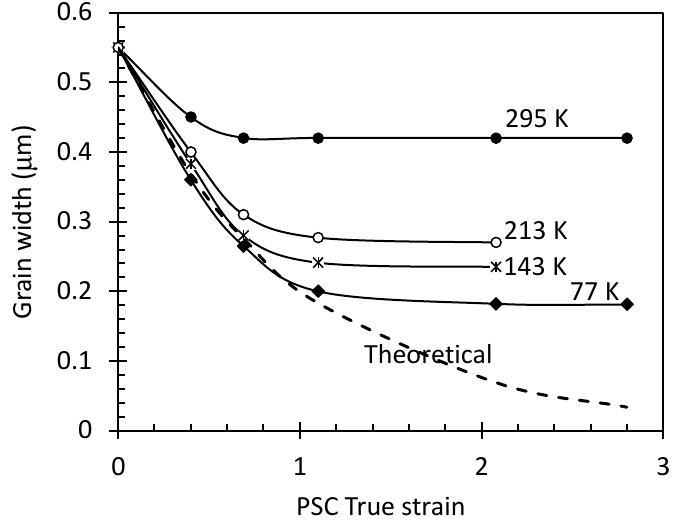
Figure 5. High angle boundary ND spacing ( λ ND ), grain width, as a function of PSC strain at different temperatures.